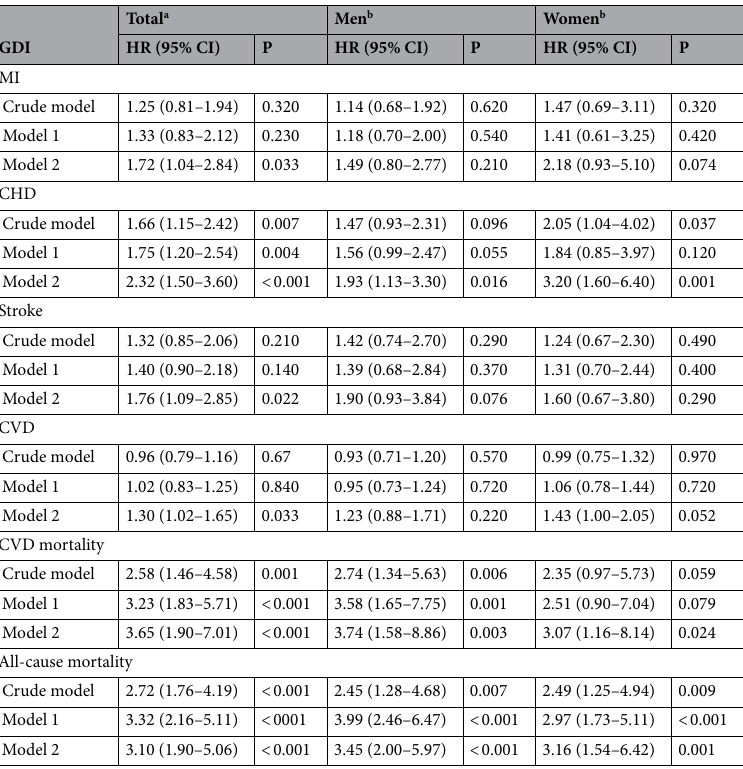
Table 4. Multiple adjusted hazard ratio and 95% confidence interval of cardiovascular diseases by global dietary index. GDI global dietary index, HR (95% CI) hazard ratio (95% confidence interval), MI myocardial infarction, CHD coronary heart disease, CVD cardiovascular disease. a Model 1: Adjusted for age (year) and sex (men/women); model 2: Additionally adjusted for education (illiterate/primary school/more than primary school), residency (urban/rural), smoking status (never/past/current smoker), daily physical activity (METs- min/day), aspirin use (yes/no), body mass index (kg/m 2 ), hypertension (yes/no) and diabetes mellitus (yes/ no) and also post menopause in women (yes/no) only in women. b Model 1: Adjusted for age (yr); model 2: Additionally adjusted for education (illiterate/primary school/more than primary school), residency (urban/ rural), smoking status (never/past/current smoker), daily physical activity (METs-min/day), aspirin use (yes/ no), body mass index (kg/m 2 ), hypertension (yes/no) and diabetes mellitus (yes/no) and also post menopause in women (yes/no) only in